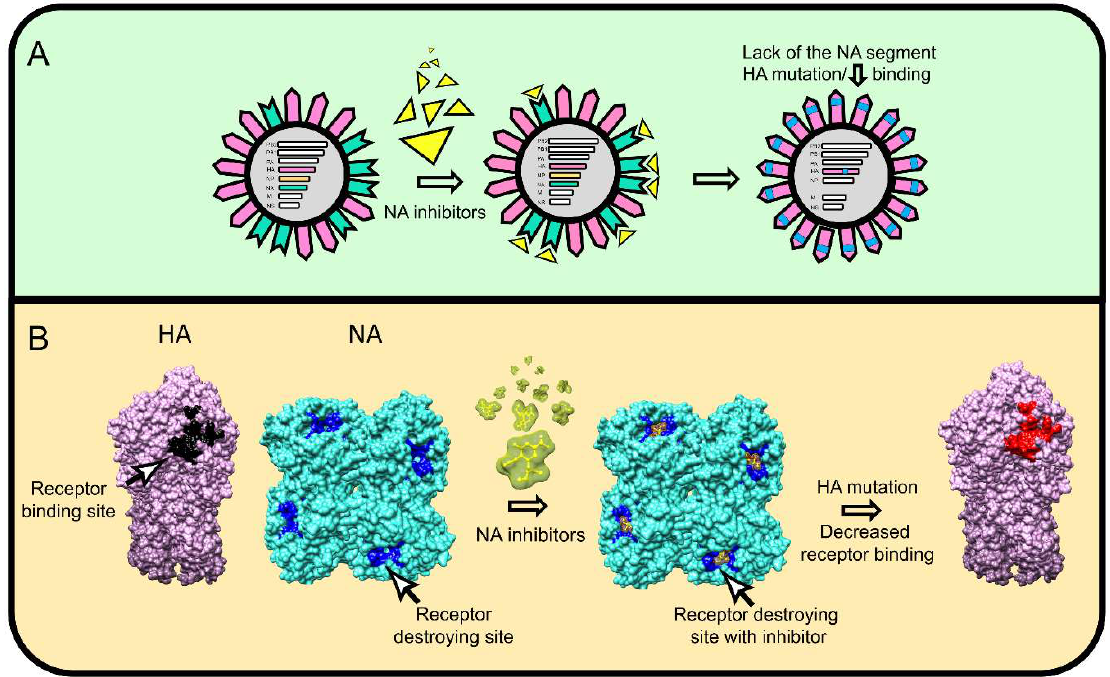
Figure 3. Naturally observed mechanisms of NA–HA epistasis. ( A ) Some oseltamivir-resistant IAV clinical isolates completely lack the NA gene segment and adapt by acquiring mutations that reduce HA receptor avidity. HA is colored pink, NA green, NA inhibitor yellow, HA mutation blue. ( B ) NA inhibitors can select escape mutants with changes exclusively in HA that alter HA receptor binding properties. The H1 HA (pdb entry 3lzg) colored pink with wt -RBS black and mutated RBS red, rendered as side view. The N1 NA colored turquoise (pdb entry 3ti6) with or without oseltamivir (yellow-green) bound to receptor destroying site (blue) rendered as top view. UCSF Chimera 1.13 software was used to visualize the molecules.